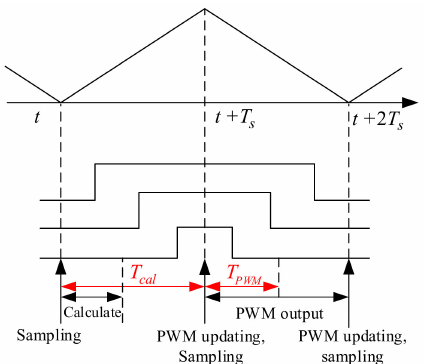
Figure 3. The digital timing diagram for the current control loop.